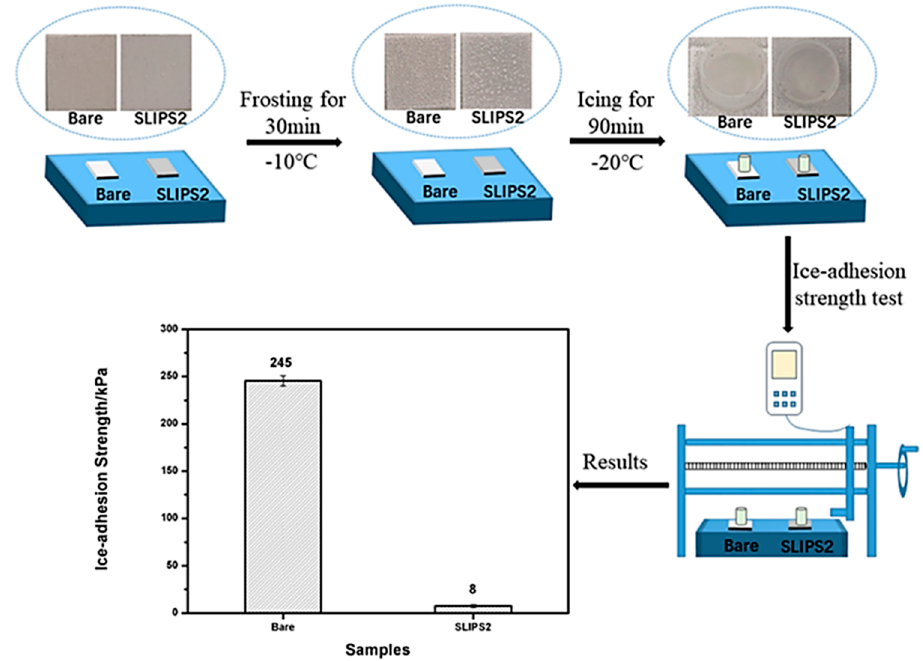
Figure 5. The process diagram of anti-icing performance test of SLIPS2 after frosting and results. Coatings 2020 , 10 , x FOR PEER REVIEW